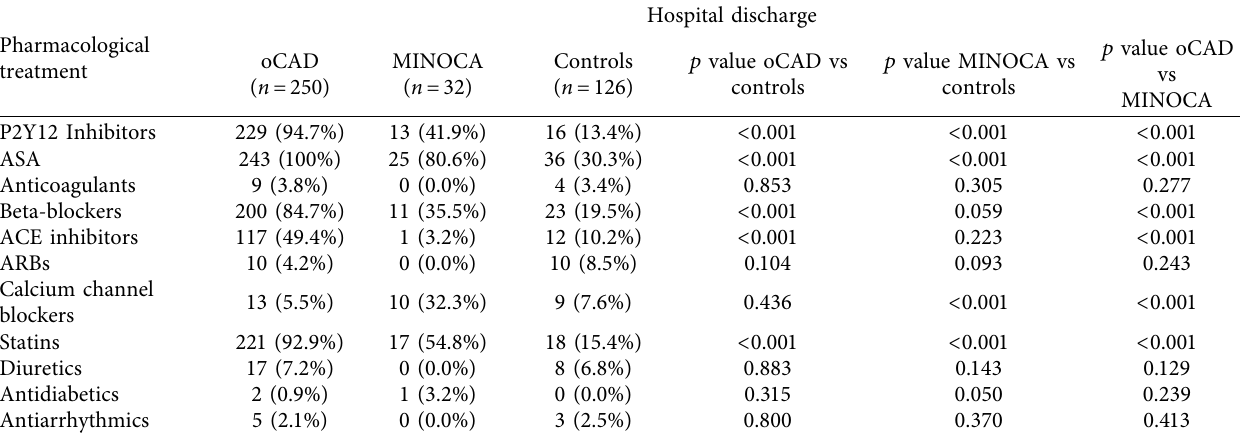
Table 3: Pharmacological treatment at hospital discharge.